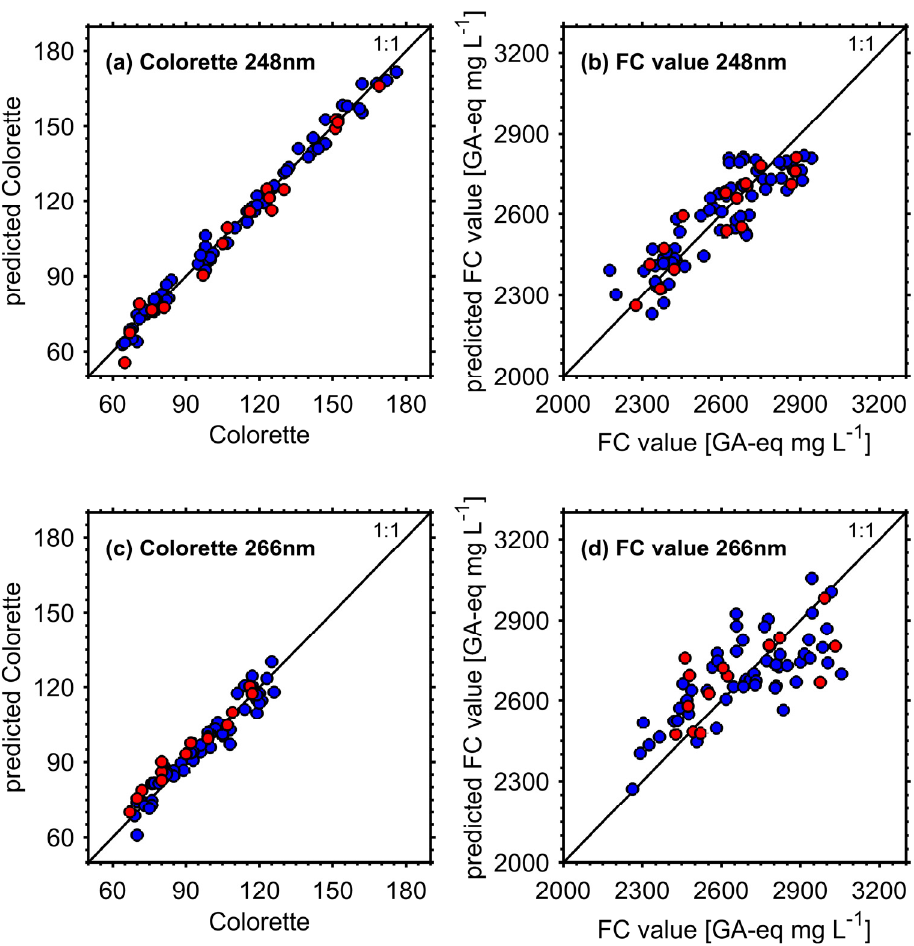
Figure 5. Relation between measured and predicted Colorette and FC values for REMPI at 248 nm (upper panels ( a , b )) and REMPI at 266 nm (lower panels ( c , d )). Blue circles refer to the calibration data set, red circles to the test set for external model validation.